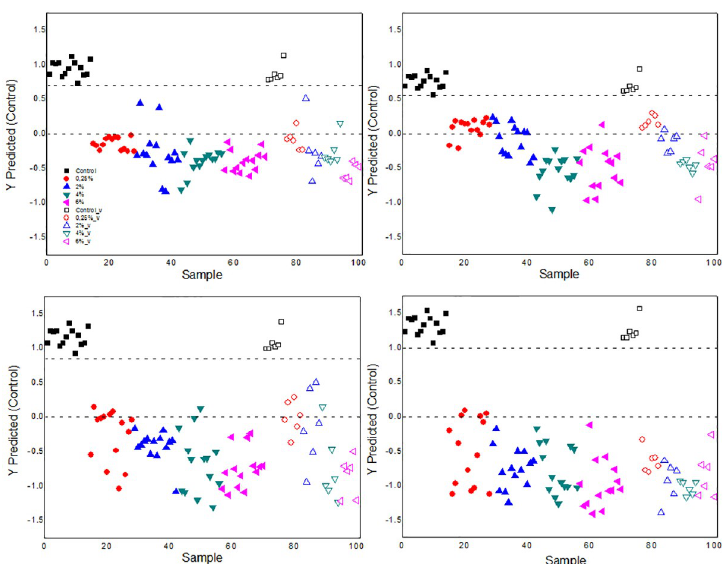
Fig 11. Results of the analysis with PLS-DA of the ROE. Behavior of the ROE from plants treated with the NPs and related to the control group. For the class model of a) 0.25, b) 2, c) 4 and d) 6% concentrations. The empty symbols correspond to the validation